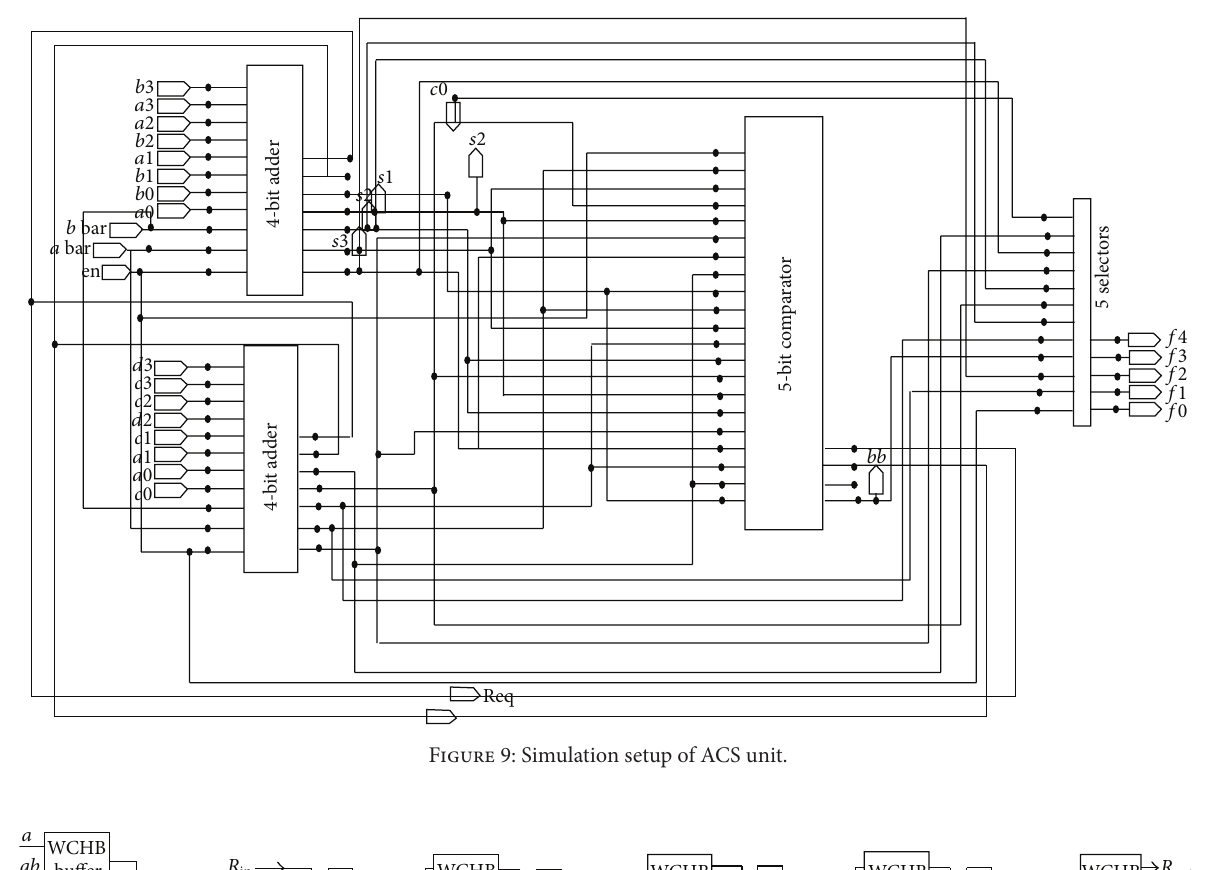
Figure 9: Simulation setup of ACS unit.